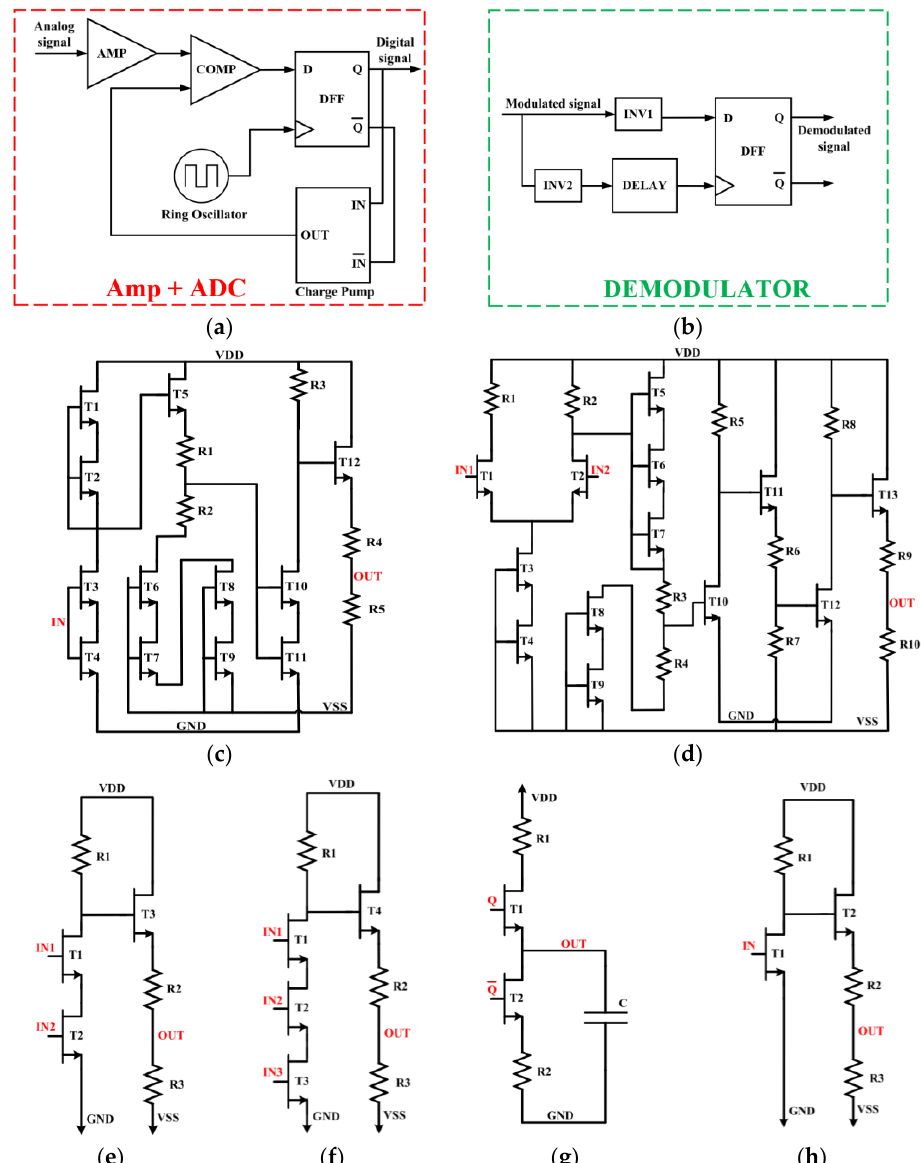
Figure 7. Data transmission system: ( a ) Block diagram of the transmitter; ( b ) Block diagram of the receiver; ( c ) Schematic of the amplifier; ( d ) Circuit diagram of the comparator; ( e ) Schematic of a 2-input NAND gate; ( f ) Schematic of a 3-input NAND gate; ( g ) Charge pump circuit; ( h ) Schematic of an inverter.